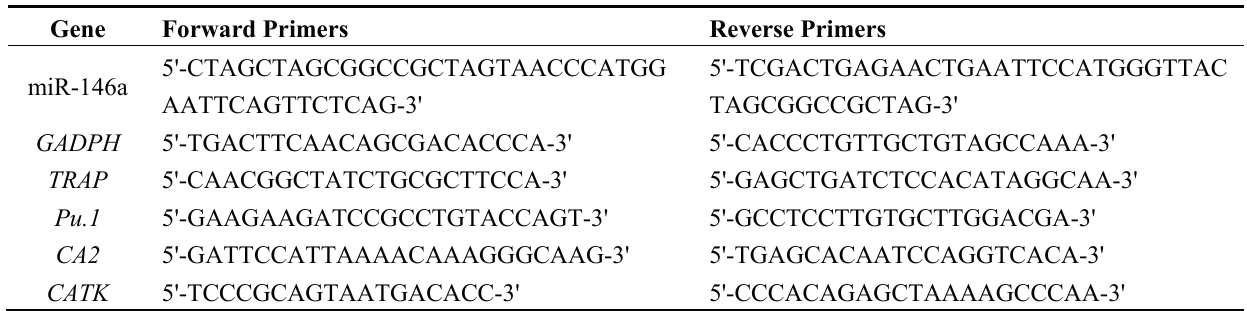
Table 1. Primers used in qRT-PCR